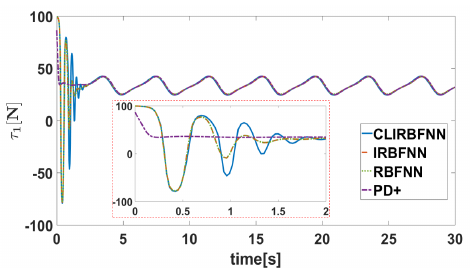
Figure 8. The torque of Joint 1.